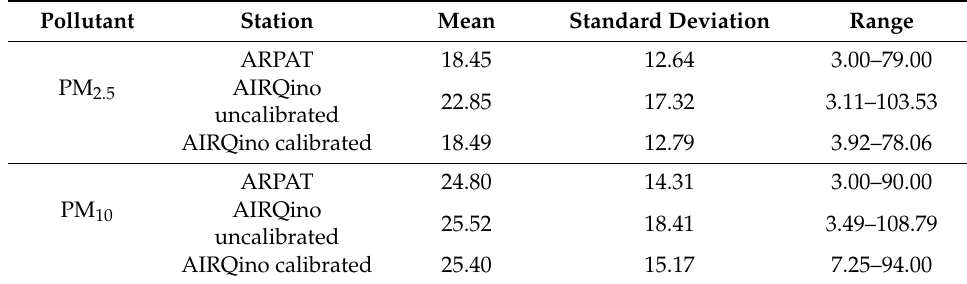
Table 5. Statistical summary of 24-h averaged PM 2.5 and PM 10 concentrations (µg/m 3 ) measured in via Bassi (Florence) by calibrated and uncalibrated AIRQino stations, and ARPAT reference station